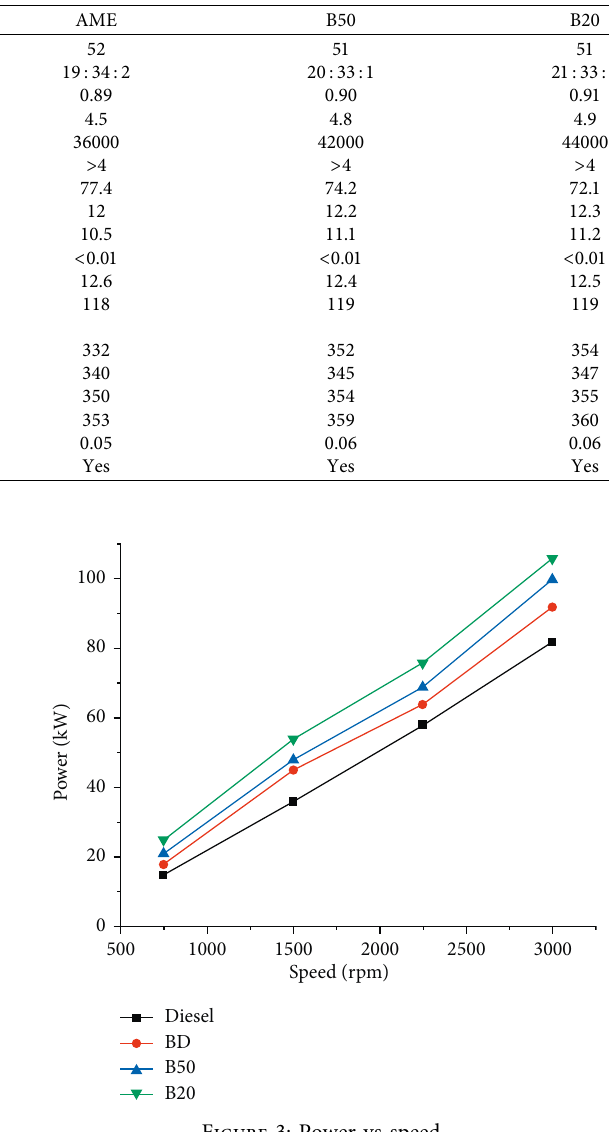
Table 3: Characteristics of biodiesel.